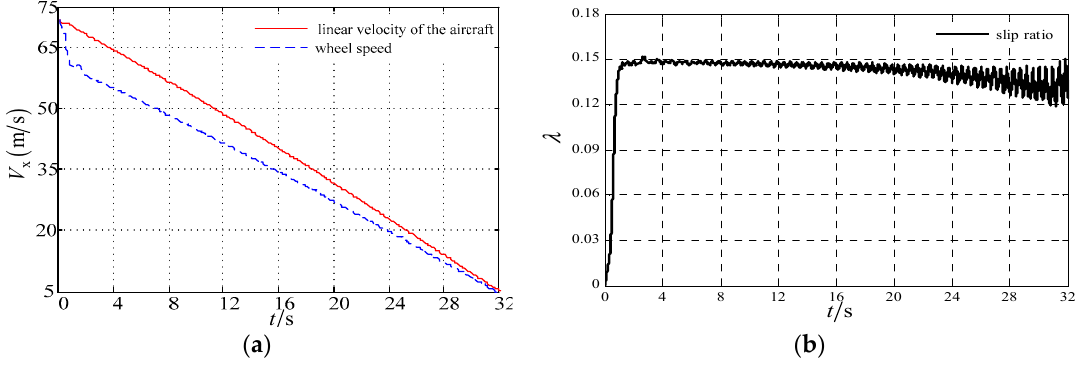
Figure 8. HIL Results. ( a ) Velocity of the aircraft and wheel speed; ( b ) Slip ratio.